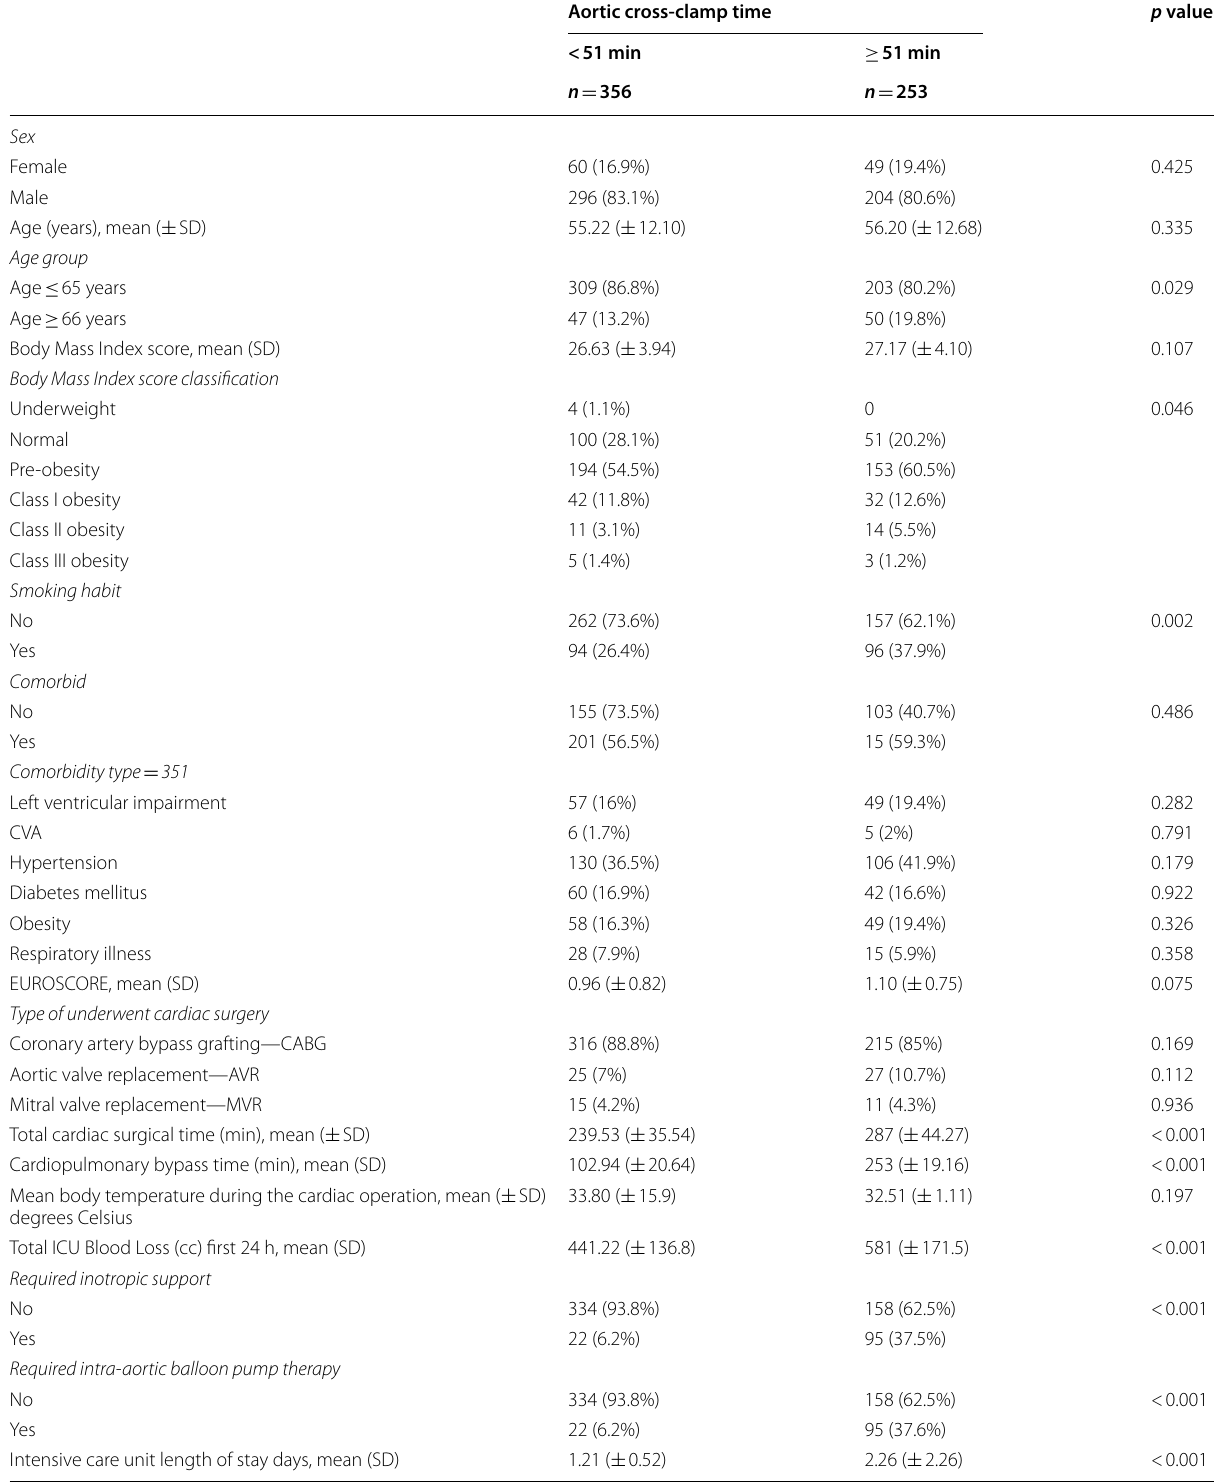
Table 3 Bivariate analysis of the cardiac surgical patients dichotomized aortic cross‑clamp time ( N